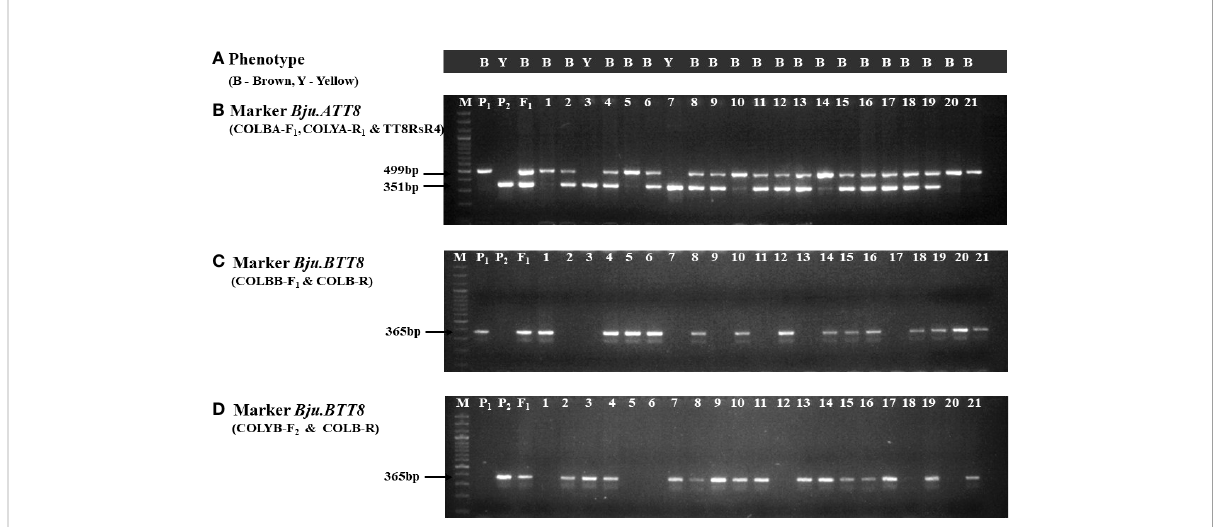
FIGURE 3 Markers segregation in F 2 population (A) Phenotype of individual F 2 plants (brown and yellow); (B) Gel image of Bju.ATT8 marker; (C, D) Gel image of Bju.BTT8 markers using two different combinations of forward primers; M-Ladder, P 1 -DRMRIJ-31, P 2 -RLC-3, F 1 -Hybrid, 1-21-F 2 plants.